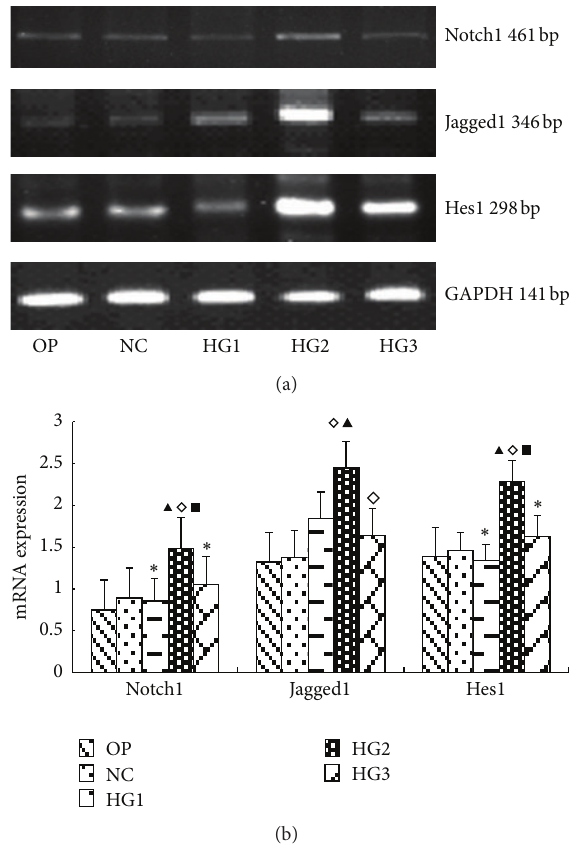
Figure 2: The mRNA levels of Notch pathway components in each group of GMCs. (a) RT-PCR strip chart for different concentrations of glucose. pathway components mRNA increased in the high glucose group, especially in HG2 group. (b) The corresponding relative gray value statistics graph of the mRNA level. ◊ 𝑃 < 0.05 versus OP group; 󳵳 𝑃 < 0.05 versus NC group; ◼ 𝑃 < 0.05 versus HG1 group; ∗ 𝑃 < 0.05 versus HG2